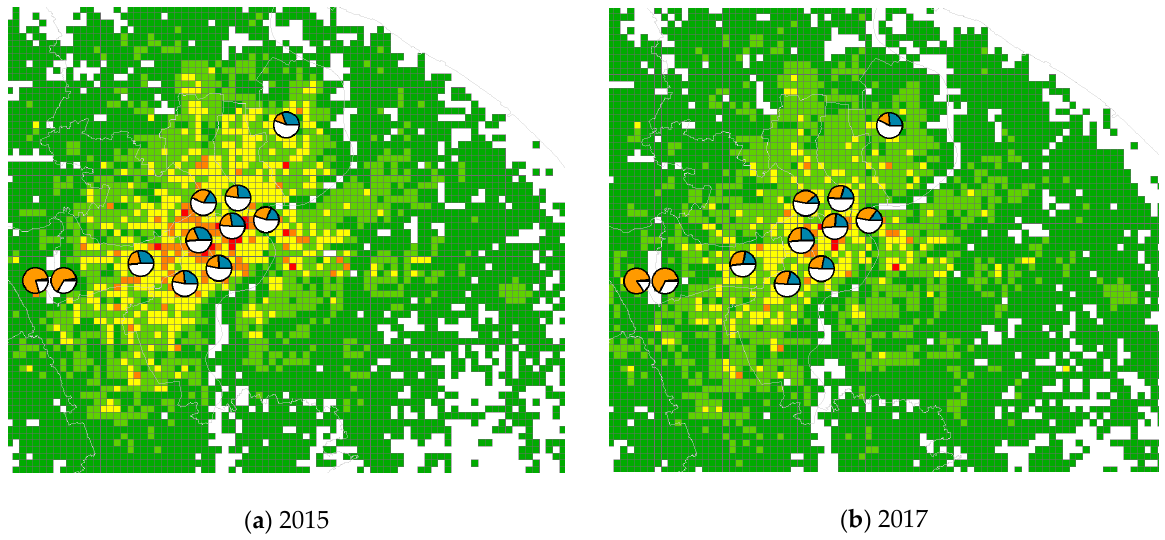
Figure 4. The short-distance occupied trip (SDOT) and long-distance occupied trip (LDOT) in each hotspot of starting points in 2015 ( a ) and 2017 ( b ). The red and blue pie chart sectors represent SDOT and LDOT, respectively. The pie charts are proportionally sized, relative to the number of the trips in each distance interval, located within the hotspots.